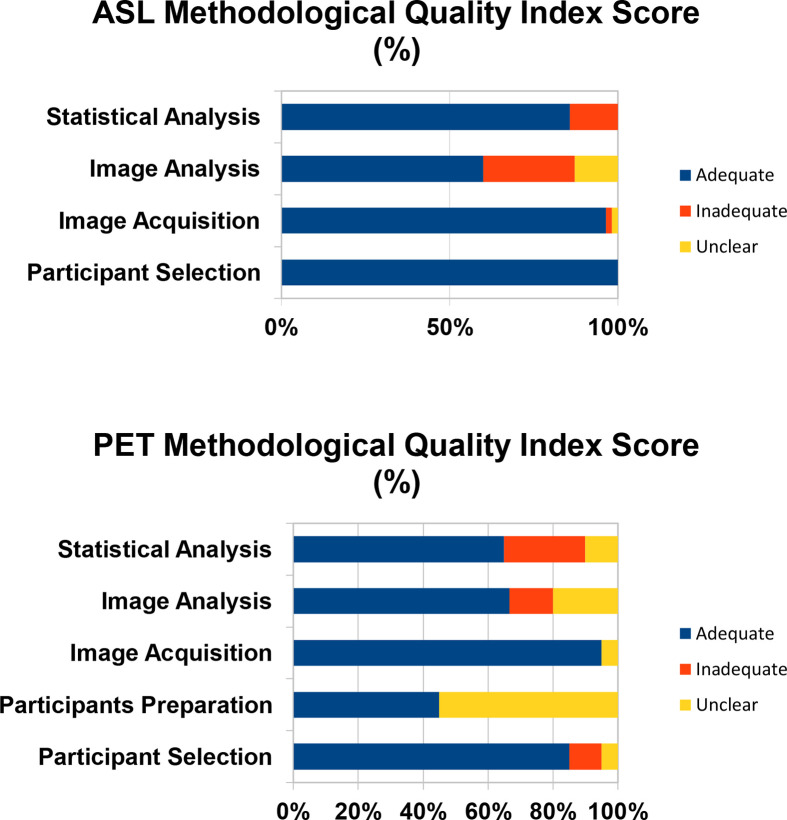
The Quality Index Score is the proportion of studies that are scored as adequate, inadequate, or unclear.